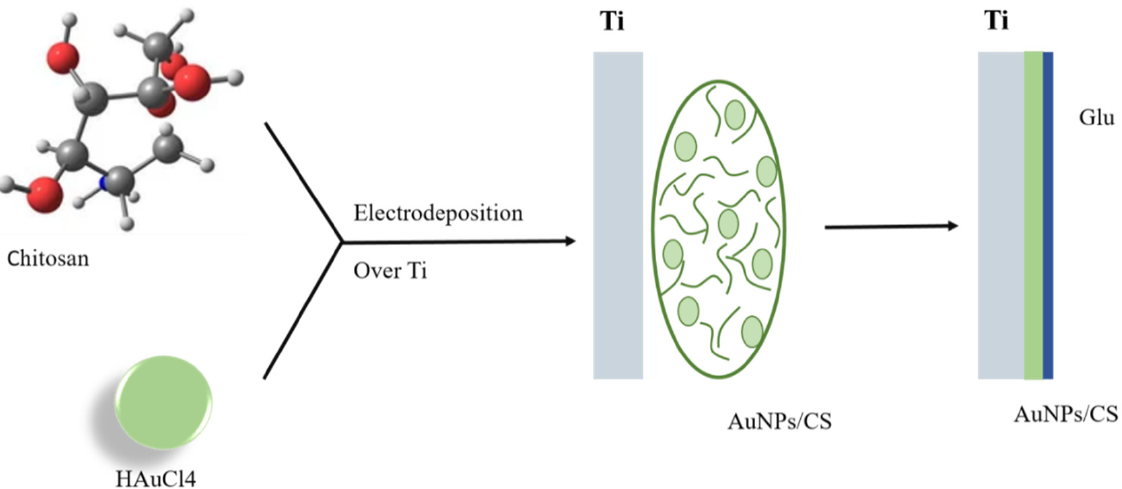
Figure 3. Schematic view of the bio nanocomposite coat from the electrodeposited bio nanocomposite film growth mechanism on the surface of Ti substrate.